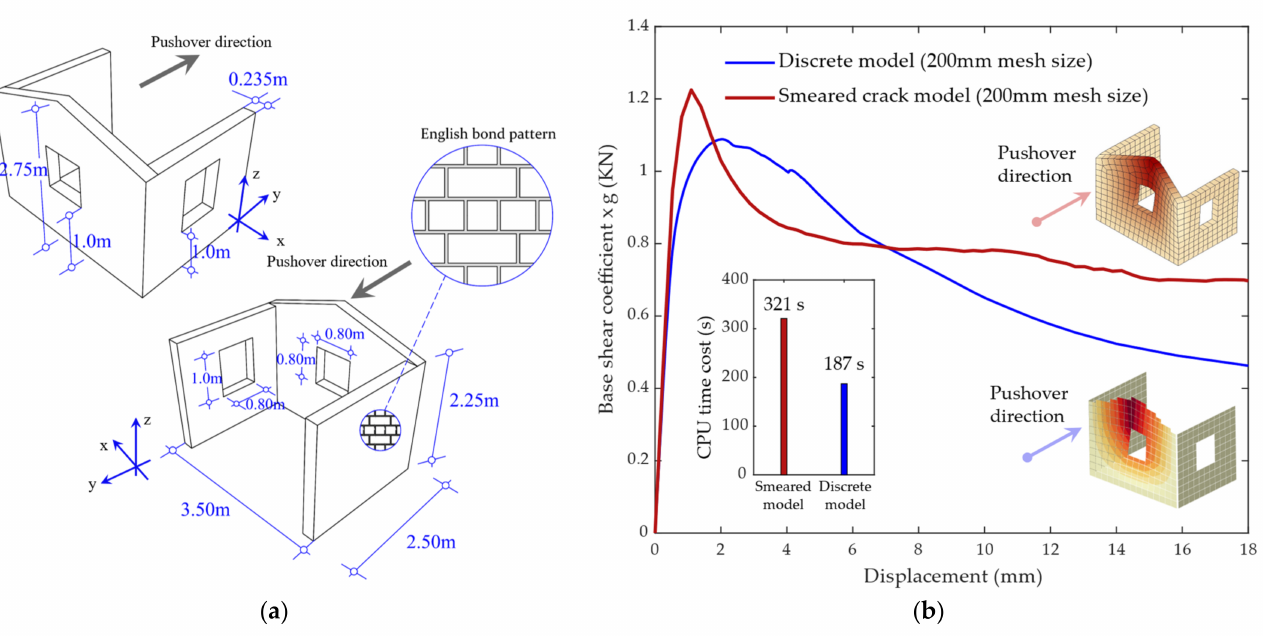
Figure 12. Capacity (pushover) curve and required CPU time for the LNEC house benchmark: comparison between the macro–element (discrete) model and smeared crack model. ( a ) Geometry of the LNEC brick house. ( b ) Capacity curves and required CPU